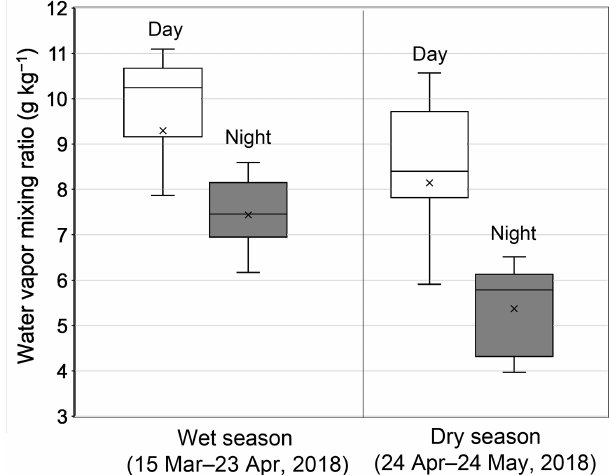
Figure 2. Box–whisker plots of the water vapor mixing ratio during the first half (15 March–23 April 2018) and second half (24 April– 24 May 2018) of the sampling period. White and gray box plots in- dicate the data for daytime (07:00–18:00LT) and nighttime (22:00– 05:00LT), respectively; medians and the upper/lower 25th per- centiles of data are shown. Cross marks indicate the average values of each category.